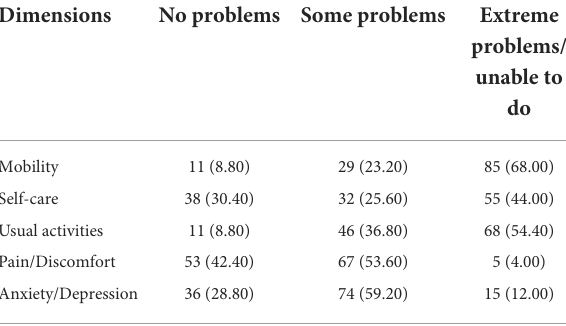
TABLE 6 Response frequencies (%) for the EQ-5D-3L ( N = 125). Dimensions